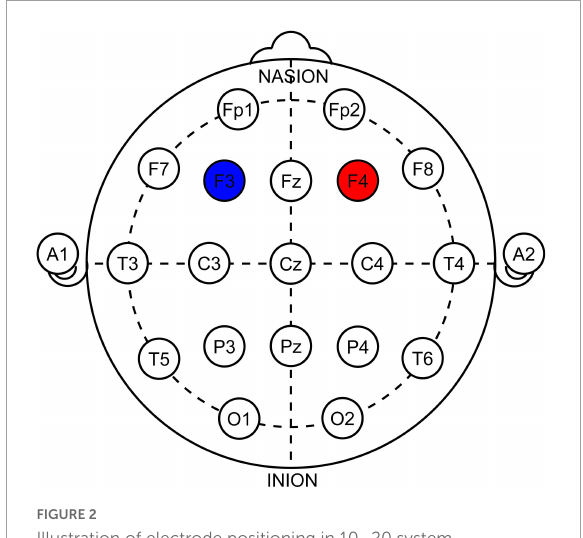
FIGURE2 Illustration of electrode positioning in 10–20 system.